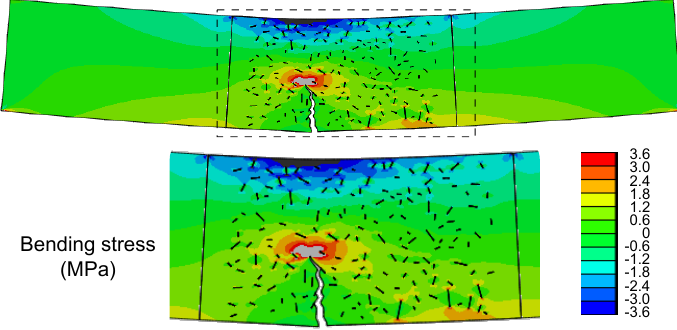
Figure 8. Stress contour of micro-scale area of concrete